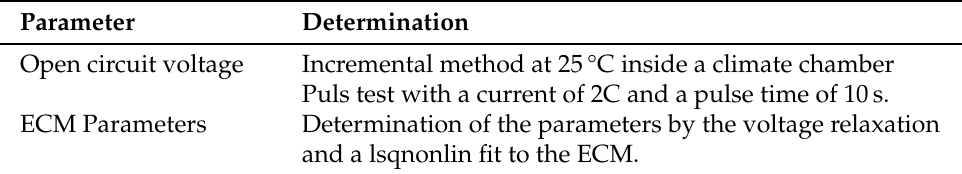
Table A1. Parameter determination of the ECM.